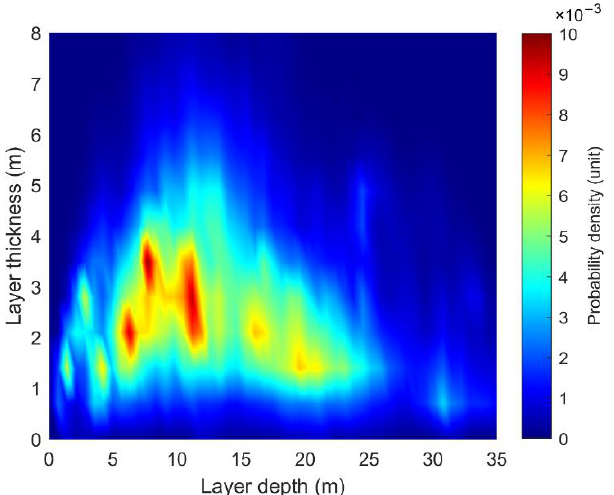
Figure 7. Two-dimensional probability distribution of thin phytoplankton layer characteristics. The detection area was divided into patches according to latitude and longitude, and the average layer depth and thickness within each patch were calculated, as shown in Figure 8. From nearshore to offshore, the color patches of layer depth change from blue to red gradually. Instead, the pattern of change in thickness is the reverse. The depth of the thin layer was shallower in the nearshore area, with an average depth of 11.5 ± 4.8 m, while the average depth in the deep area was 16.9 ± 7.75 m. The average thickness of the thin layer in the shallow water area is 3.5 ± 1.7 m, while in the deep area it is 3.0 ± 1.6 m.